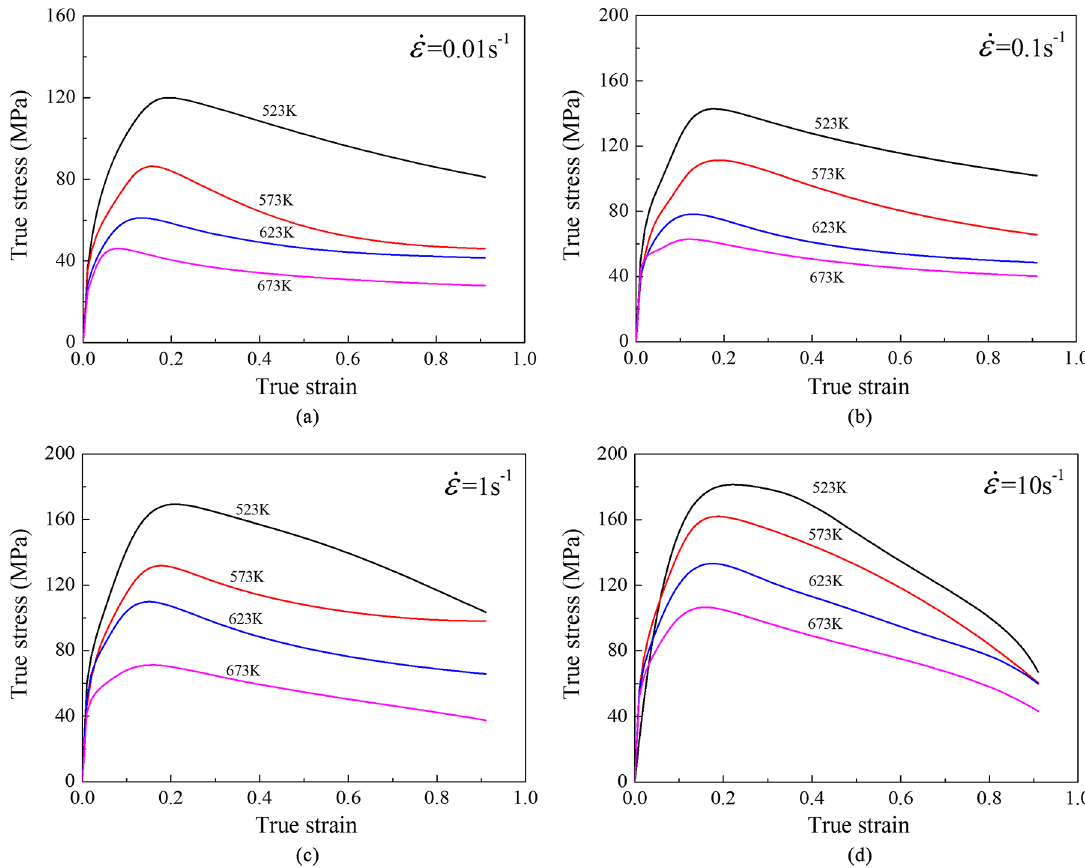
Figure 2. True stress-strain curves for as-cast AZ80 magnesium alloy under different temperatures and strain rates of: (a) 0.01 s –1 , (b) 0.1 s –1 , (c) 1 s –1 , (d) 10 s –1